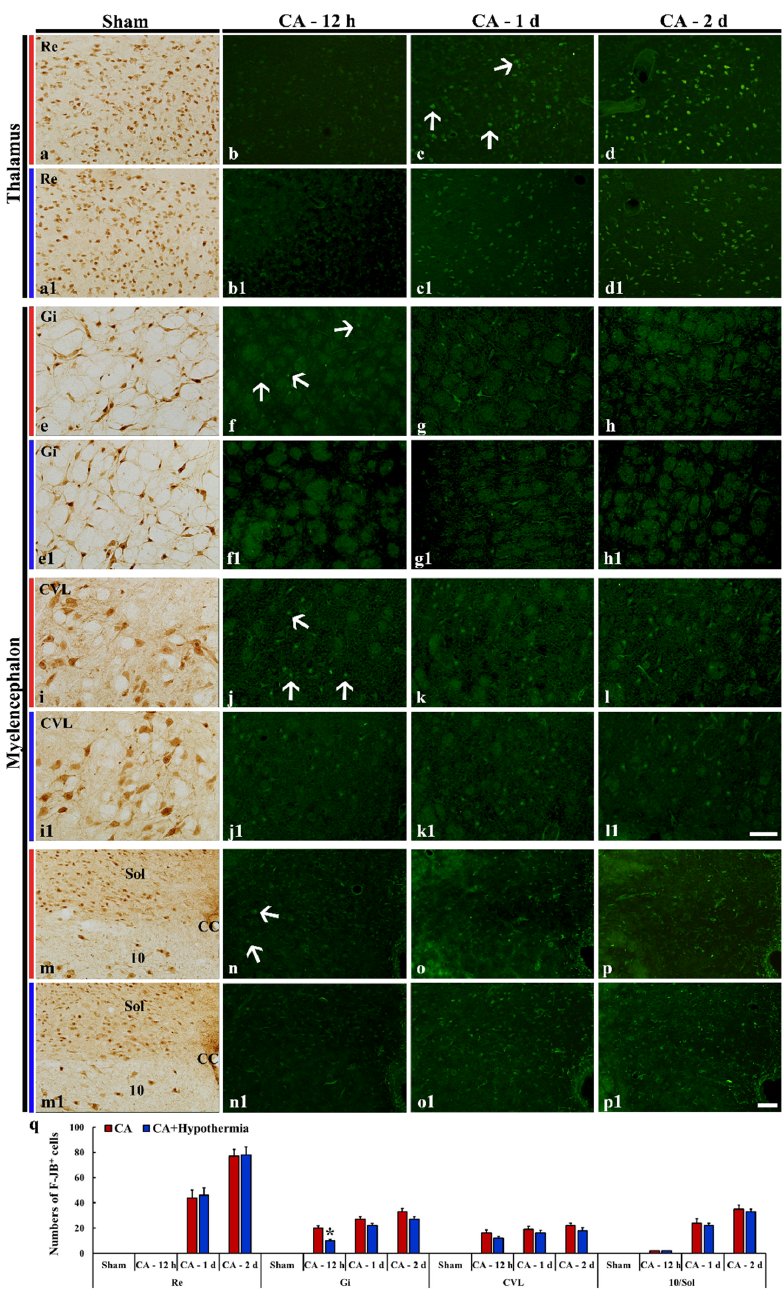
Figure 3. NeuN immunohistochemical staining in the thalamus ( a , a1 ) and myelencephalon ( e , e1 , i , i1 , m , m1 ) in the sham group, and F-J B histofluorescence staining in the thalamus ( b – d , b1 – d1 ) and myelencephalon ( f – h , f1 – h1 , j – l , j1 – l1 , n – p , n1 – p1 ) of the CA operated ( b – d , f – h , j – l , n – p ) and CA/hypothermia operated ( b1 – d1 , f1 – h1 , j1 – l1 , n1 – p1 ) groups. In the thalamus, F-JB positive cells (arrows) are shown and in the reuniens thalamic nucleus (Re) from 1 day post-CA. In the myelencephalon, F-JB positive cells (arrows) are found in the gigantocellular reticular nucleus (Gi), caudoventrolateral reticular nucleus (CVL), solitary nucleus (Sol) and dorsal motor nucleus of vagus (10). From 12 h post-CA, hypothermia significantly reduces the number of F-JB positive cells only in the Gi at 12 h post-CA. Scale bar = 100 µ m. ( q ) mean numbers of F-JB positive cells in the CA and CA/hypothermia groups ( n = 9 per group, * p < 0.05, vs. each CA group). The bars indicate the means ±